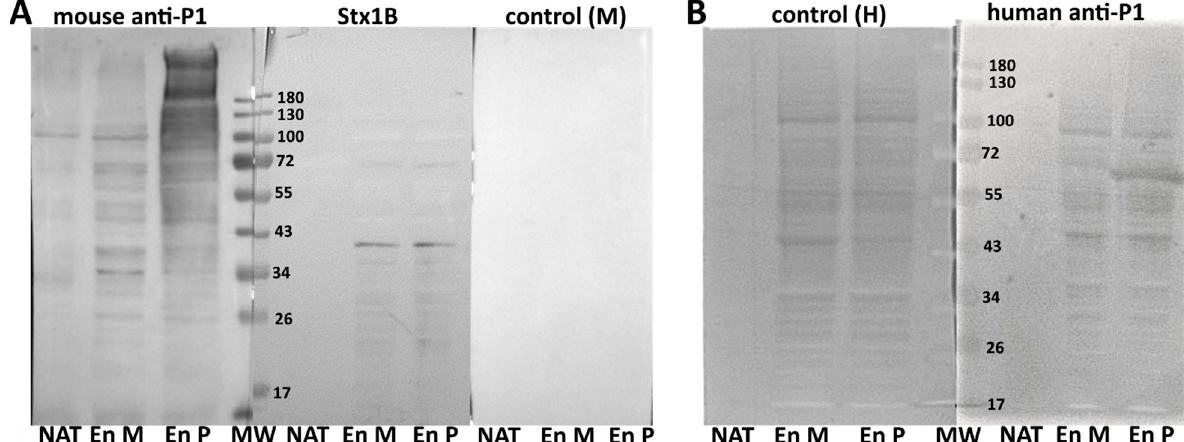
Figure 5. Western blotting of 2102Ep transfected with vectors encoding the M and P enzymes: ( A ) mouse anti-P1 antibody and Stx1B binding to protein lysates isolated from 2102Ep cells transfected with the genes encoding M and P enzymes. Control (M): secondary antibody only. ( B ) Human anti-P1 antibody binding to protein lysates isolated from 2102Ep cells transfected with the M and P genes with a negative control without primary antibody (control (H). MW (kDa): molecular weight standard Page Ruler PreStained (Thermo Fisher Scientific, Waltham, MA, USA); NAT: nontransfected 2102Ep cells; EnP: 2102Ep cells transfected with the vector encoding enzyme P; EnM: 2102Ep cells transfected with the vector encoding enzyme M.